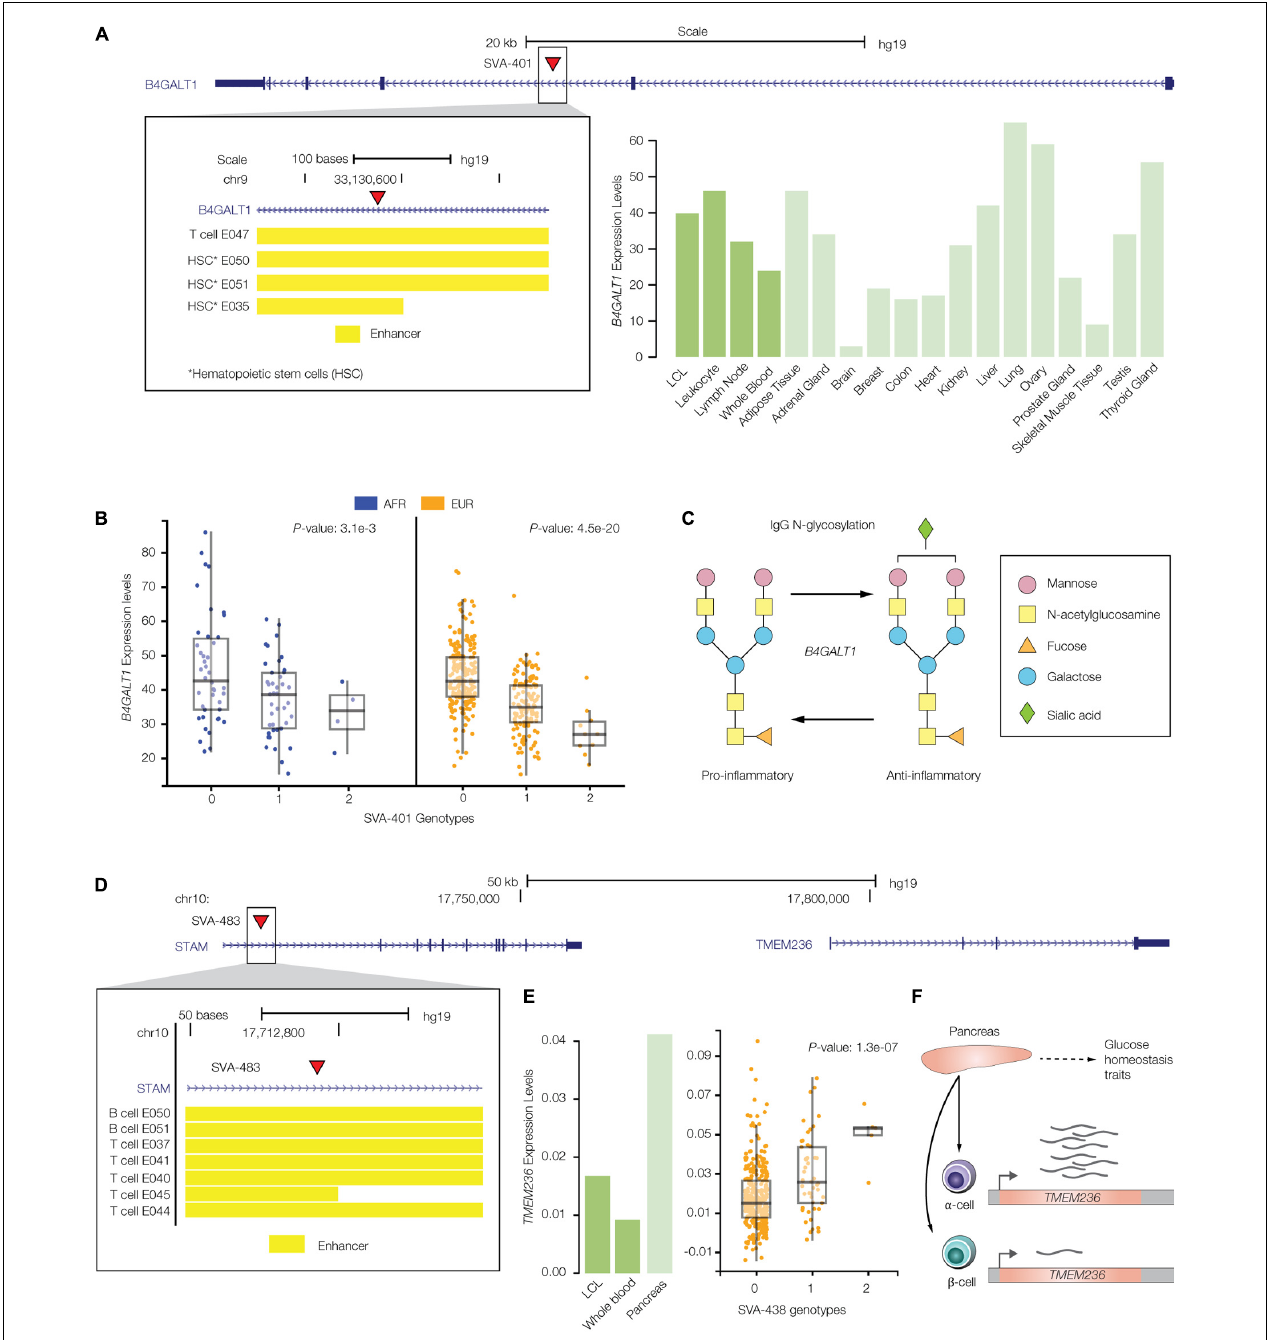
FIGURE 7 | PolyTE insertions associated with immune- and blood-related conditions. (A) UCSC Genome Browser screen capture showing the location of the SVA-401 insertion (red arrow) on chromosome 19 within the second exon of the B4GALT1 gene. The inset shows the genomic locations of co-located enhancers, characterized based on chromatin signatures from a variety of tissue-specific epigenomes locations, as yellow bars. The bar-chart shows B4GALT1 tissue-specific expression levels as normalized RPKM values (green). (B) eQTL box-plots show individual sample gene expression levels ( y -axis) regressed against SVA-401 insertion presence/absence genotypes ( x -axis): 0-homozygous absent, 1-heterozygous, 2-homozygous present. Each dot represents a single individual from the African (AFR – blue) or European (EUR – orange) population groups. (C) B4GALT1 catalyzed glycosylation of the Immunoglobulin G (IgG) antibody, resulting in conversion from pro- to anti-inflammatory activity. (D) UCSC Genome Browser screen capture showing the location of the SVA-438 insertion (red arrow) on chromosome 10 within the first exon of the STAM gene, upstream of the regulated TMEM236 gene. The inset shows the genomic locations of co-located enhancers (yellow bars). (E) Bar-chart of TMEM236 tissue-specific expression levels and box-pot of the SVA-438 TMEM236 eQTL analyses. (F) Functional role and cell-type specific expression profile for TMEM236 .